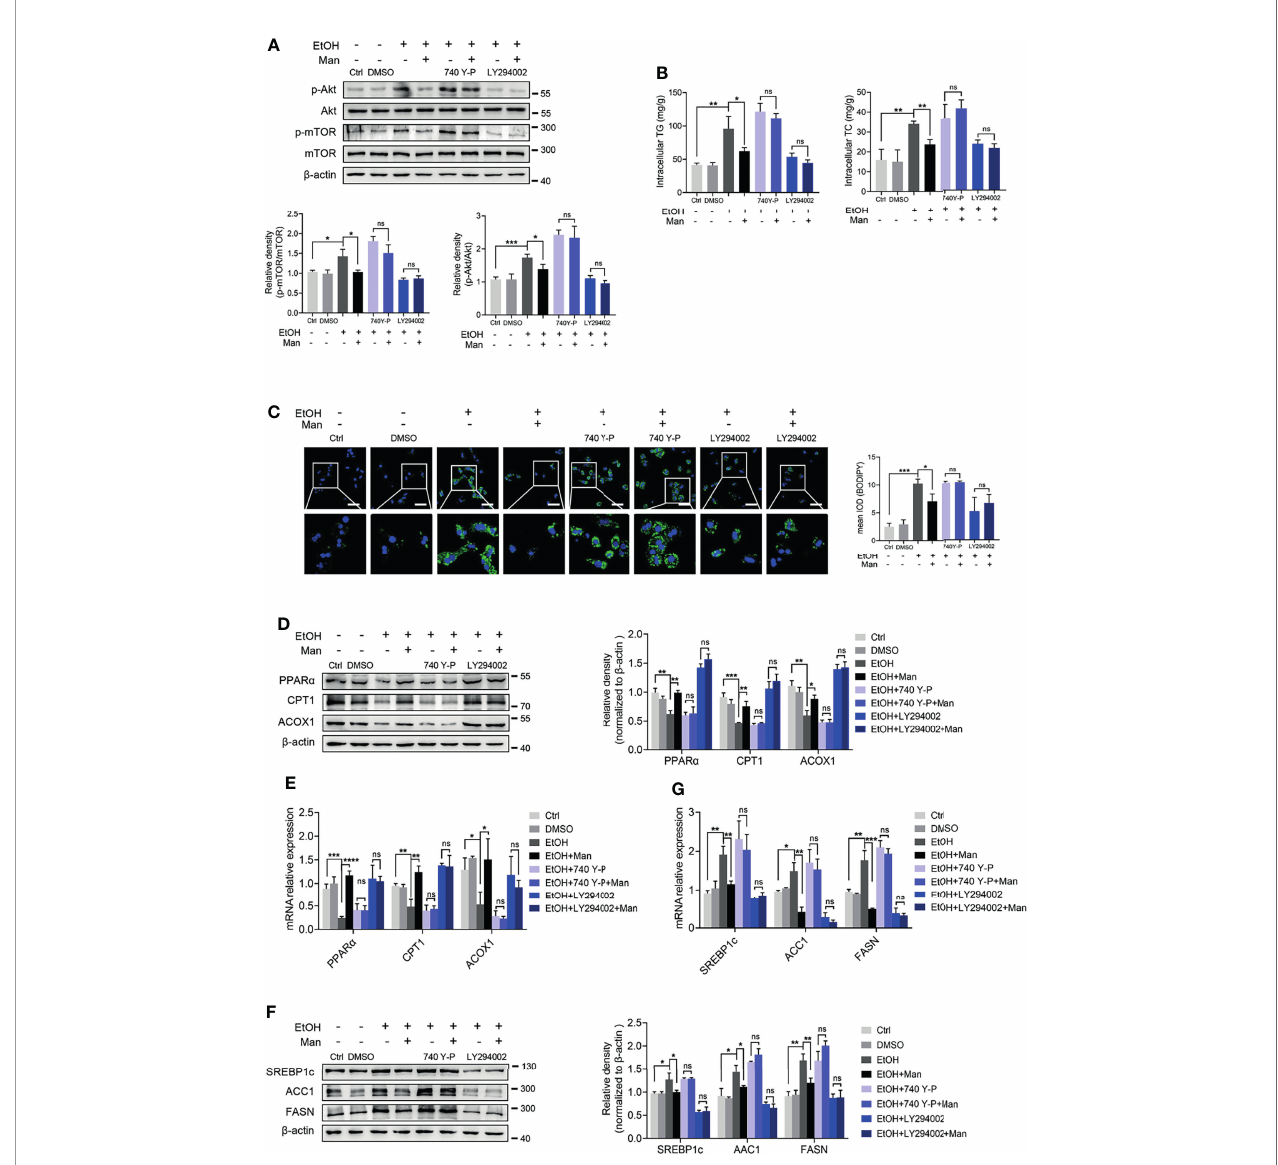
FIGURE 7 | PI3K-mediated Akt/mTOR activation involves mannose-mediated improvement of ethanol-induced lipid accumulation in PMHs. PMHs from WT mice were pretreated with 740 Y-P (PI3K agonist, 20 m g/ml) or LY294002 (PI3K inhibitor, 20 m M) for 2 h (DMSO as control), ahead of treatment with 200 mM ethanol (EtOH) and 5 mM mannose (Man) or culture medium (Ctrl) for 24 h (n = 3). (A) Akt, p-Akt, mTOR and p-mTOR expressions were evaluated. (B) Cellular content of TG and TC levels were determined. (C) The intracellular levels of neutral lipids were determined by BODIPY 493/503 staining assay. (D – G) Western blotting and qRT-PCR analysis for protein and mRNA levels of lipid-regulating genes. Scale bars = 50 m m. Data are expressed as the mean ± SEM of three independent experiments. * p < 0.05, ** p < 0.01, *** p < 0.001, **** p < 0.0001, ns, not signi fi cant, unpaired two-tailed t